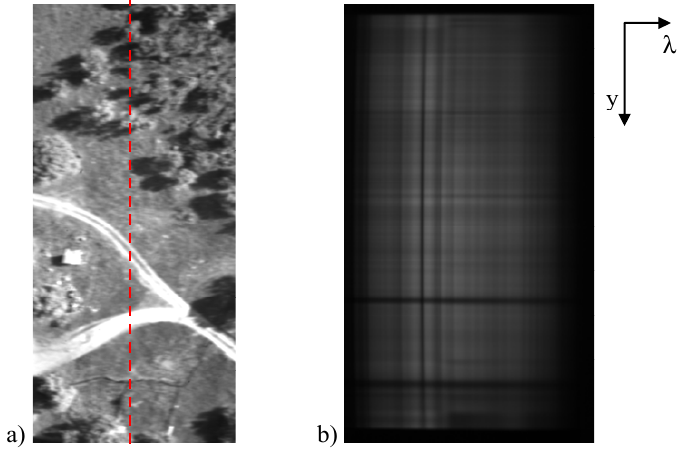
Figure 11. Sample images acquired by ( a ) the 4M60 camera equipped with a standard lens and ( b ) the VIS spectral imaging